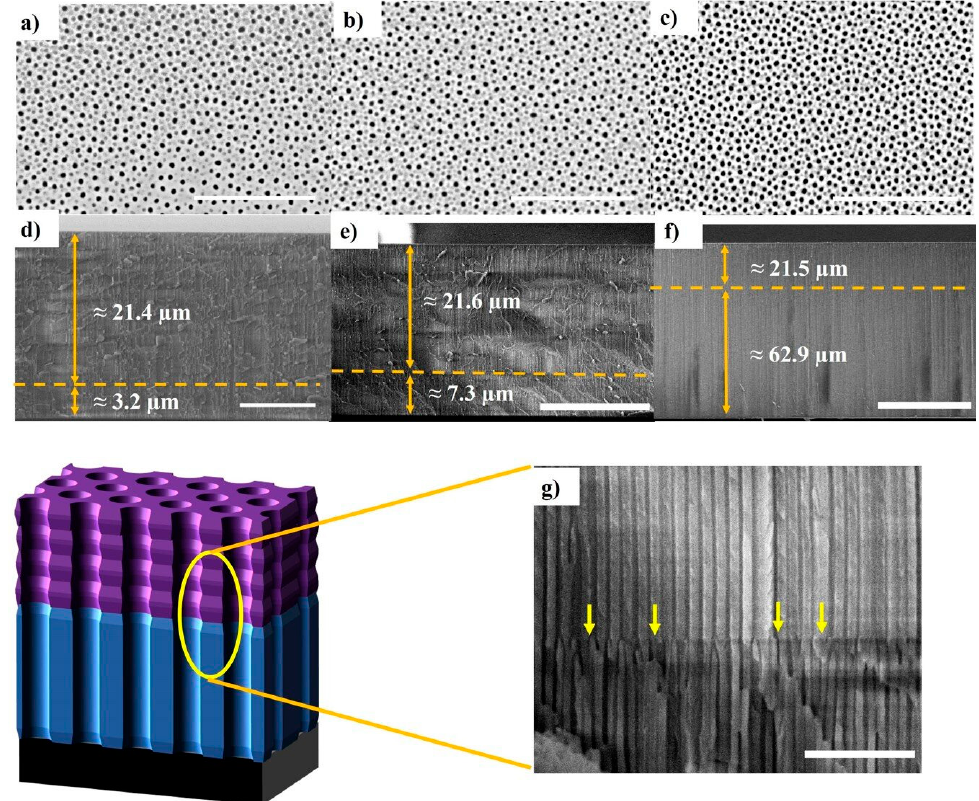
Figure 3. SEM pictures of Hy-NAA-GIF structure obtained with the sinusoidal parameters, j 0 = 2.6 mA/cm 2 , j 1 = 1.3 mA/cm 2 ; T = 133 s, N = 150 periods and different current-density vs. time parameters. ( a – c ) represents top view (Scale bar = 1 µm) and ( d – f ) demonstrates cross-section (scale bar = 10, 20 and 50 µm respectively) for the short, medium, and long samples respectively. ( g ) interface between the modulated pore and straight pore parts of the structure caused by the change in the anodization process indicated by arrows.